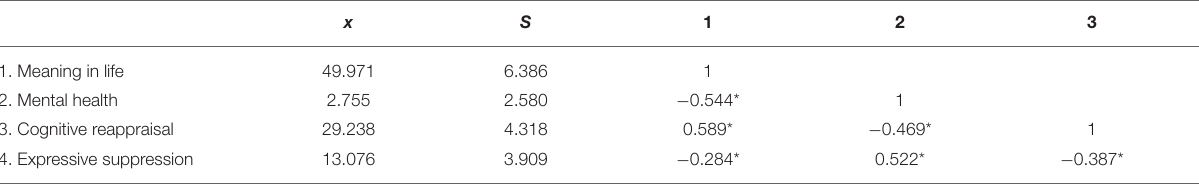
TABLE 1 | Correlation analysis between meaning in life, emotion regulation, and mental health of frontline nurses.